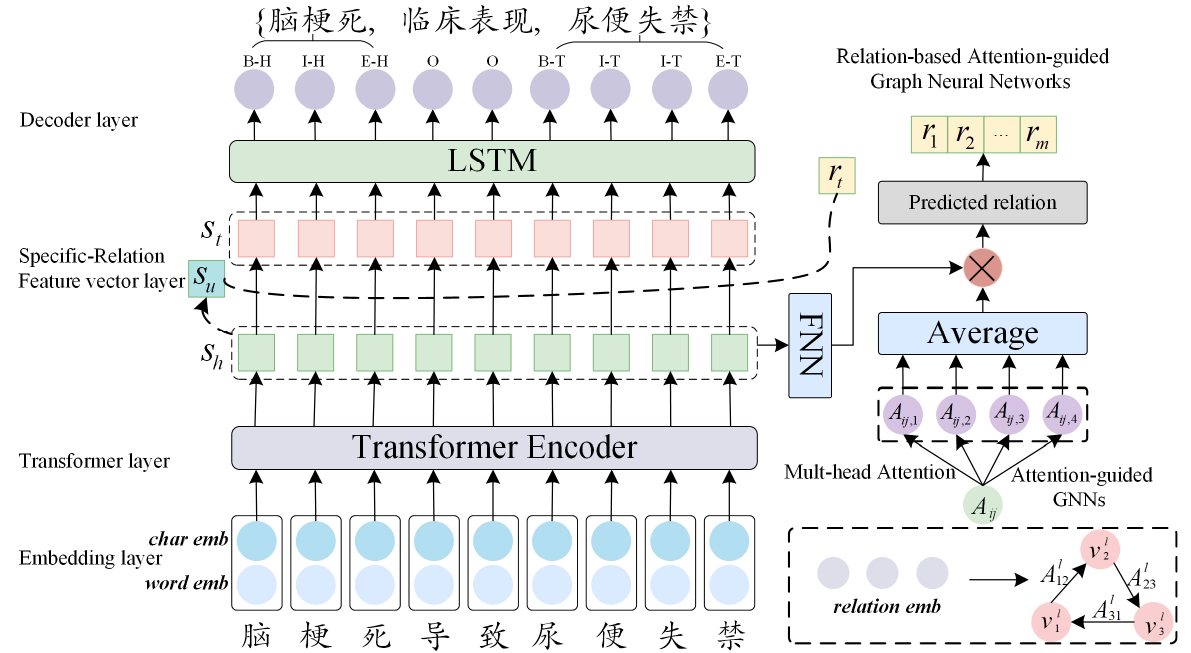
Figure 1. The overall architecture of the proposed SRAGNNs model. The Transformer is used to encode the input sentence and extract the sentence context features. The GAT is used to learn the correlation between each relation, combined with the sentence context features encoded by the transformer, to fully capture the semantic information, and to extract the relation. For the example input sentence in the figure, the model extracts the head entity “ 梗死 (cerebral infarction)” and the tail entity “ 尿便失禁 (urine fecal incontinence)”, and combine this entity pair with 𝑟 𝑡 to return the triplets {“ 脑 梗 死 (cerebral infarction)”,“ 临床表现 (clinical manifestations)”,“ 尿便失禁 (urine fecal incontinence)”}.